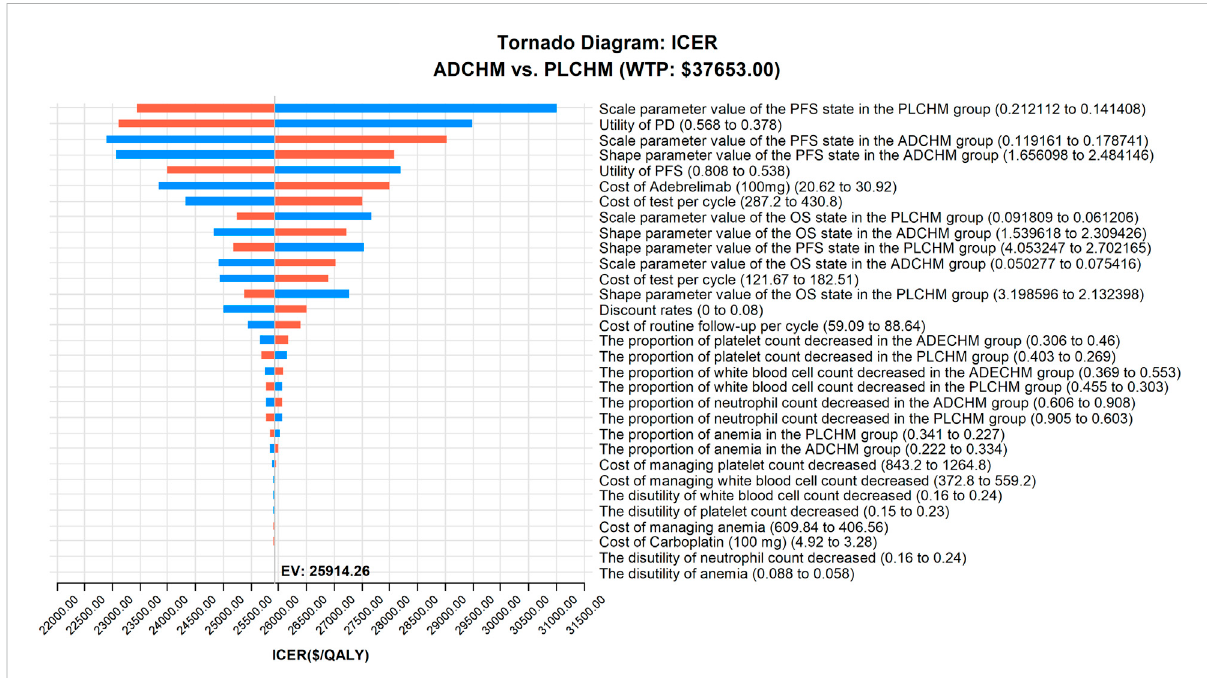
FIGURE 2 One-way sensitivity analyses of ADCHM in comparison with PLCHM. ADCHM: adebrelimab in combination with chemotherapy (etoposide- carboplatin); ES-SCLC: extensive-stage small-cell lung cancer; ICER: incremental cost-effectiveness ratio; PD: progressive disease; PFS: Progression-free survival; PLCHM: placebo plus chemotherapy